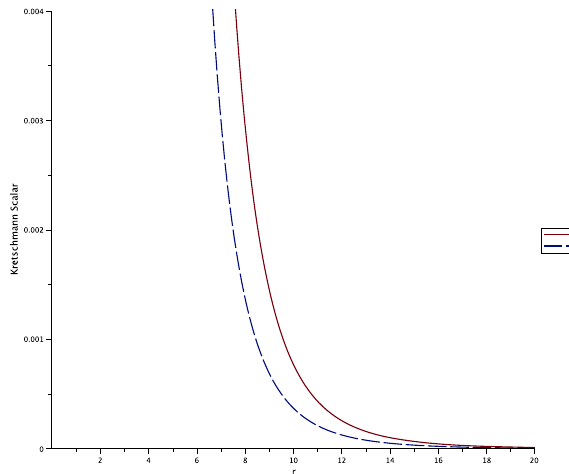
Fig. 3 Plot of the Kretschmann scalar, for EA parameters c 14 = 16 / 9, α = − 1 and an arbitrary Schwarzschild mass M = 4. The continuous red line represents the GR Schwarzschild metric. The dashed blue line represents the EA solution. Calculating the limit r → +∞ we obtain K → 0. Calculating the limit from left r → r sing 1 = 0 we get K → −∞ , as we can see in this figure. Calculating the limit from right r